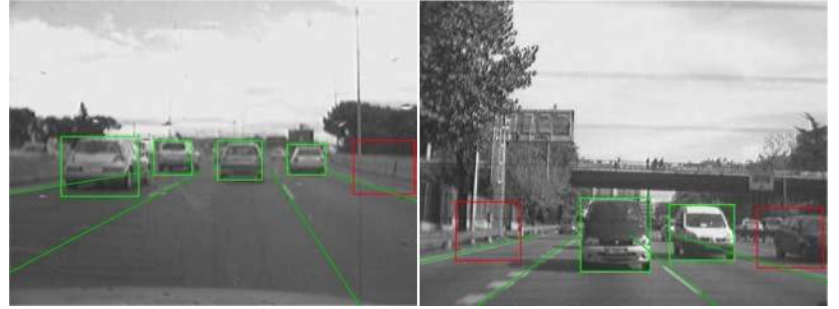
Figure 12. Linear SVM with HOG features single-frame classification examples: non-vehicles are depicted with red boxes whereas vehicles are depicted with green ones.